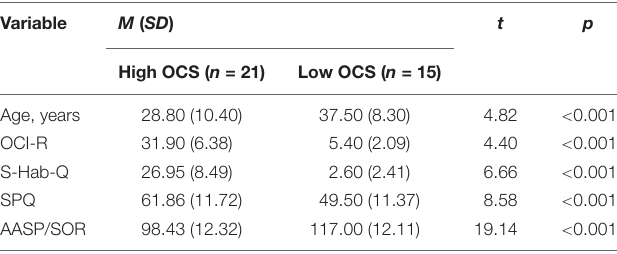
TABLE 4 | Characteristics comparison of high- and low-obsessive–compulsive symptoms (OCS) groups.